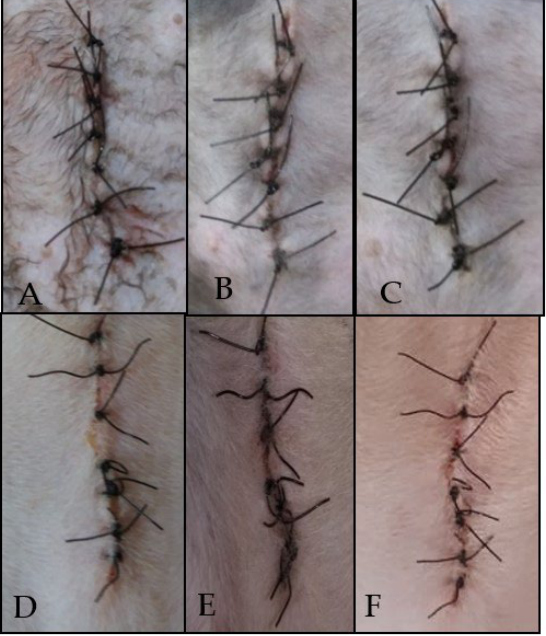
Figure 3. Action of pyroligneous extract Mimosa tenuiflora 20% on day 1 ( A ), day 3 ( B ), day 7 ( C ) and chlorhexidine to 0.5% on day 1 ( D ), day 3 ( E ) and day 7 ( F ) in surgical wounds of cats submitted to ovariosalpingohysterectomy.